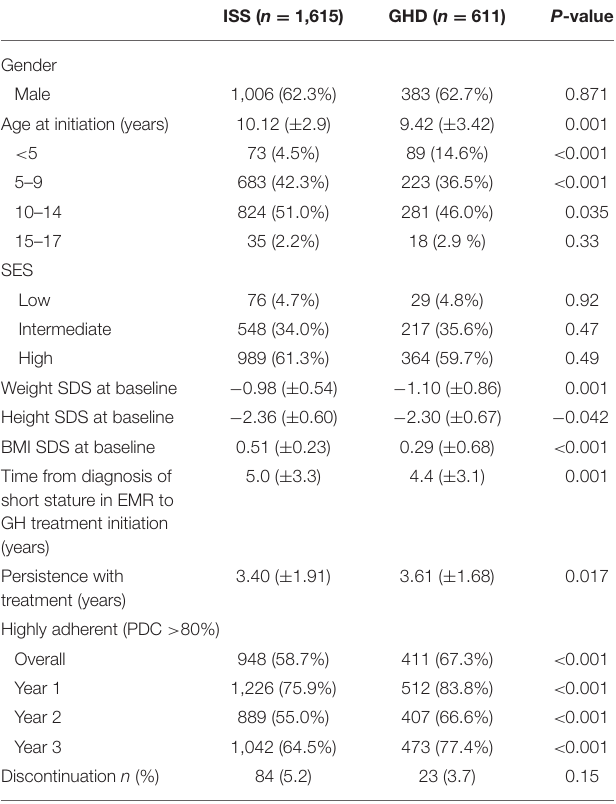
TABLE 1 | Baseline characteristics and treatment